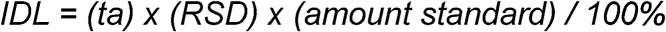
The equation for the instrument detection limit (IDL).